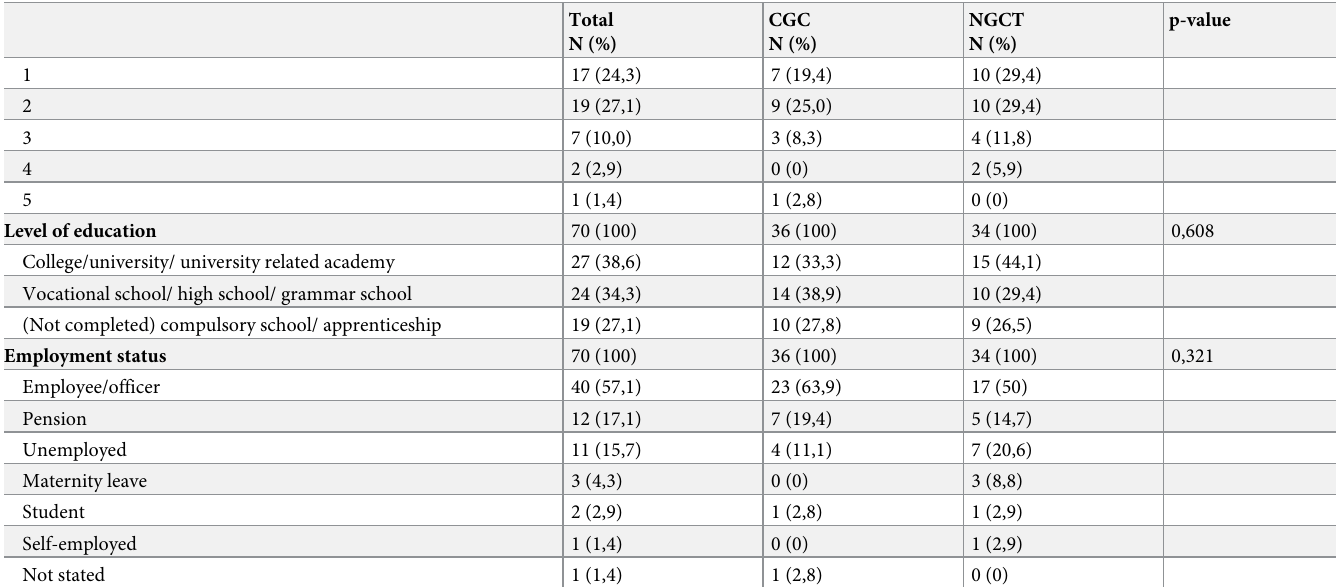
than the NGCT group (1.56 (SD = 1.48) vs 1.03 (SD = 1.17), respectively) but the difference was not statistically significant (p =